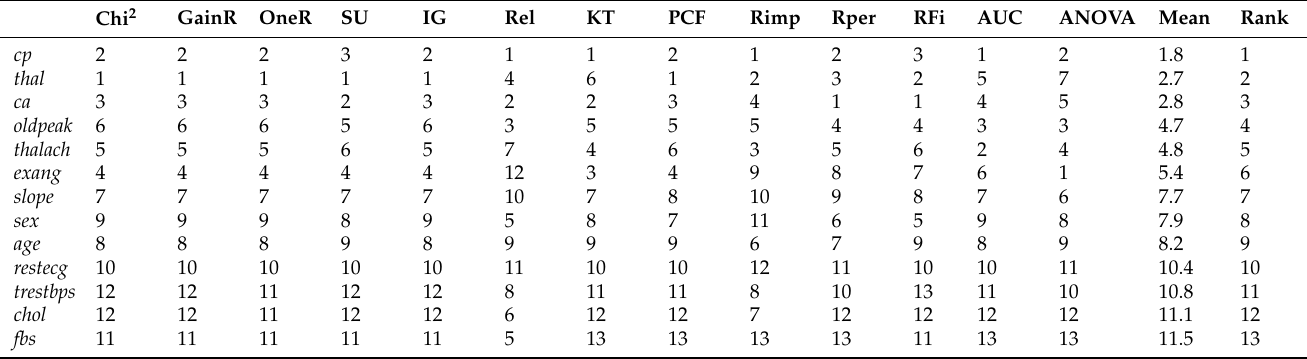
Table 2. Importance metrics.